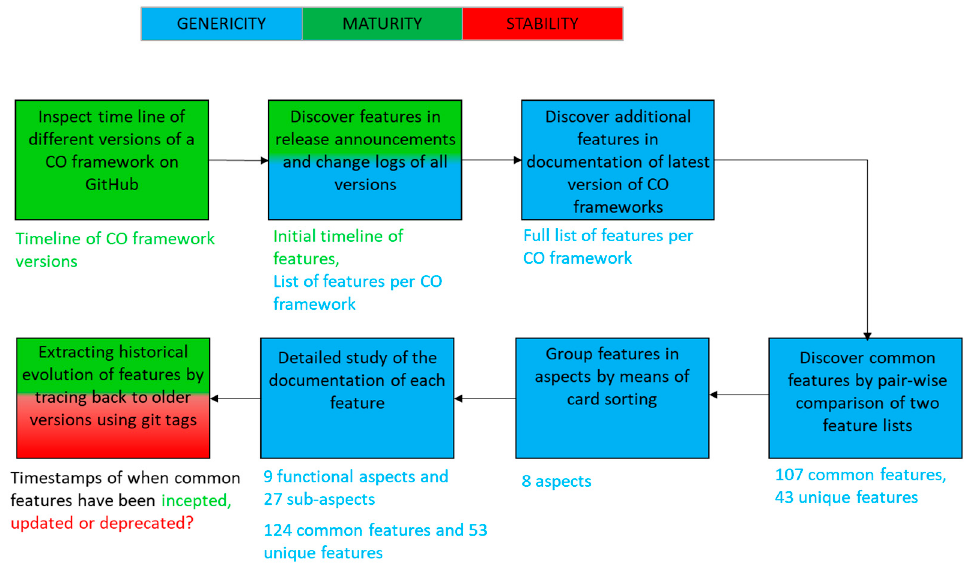
Figure 3. Overview of the method for collecting data from GitHub with respect to genericity, maturity and stability. The top of the diagram shows the 7 successive steps performed. Each step produced specific data that is related to one or more software quality properties. Each of these software qualities are presented by a colored bar. For each step, the extracted data items are specified directly below.